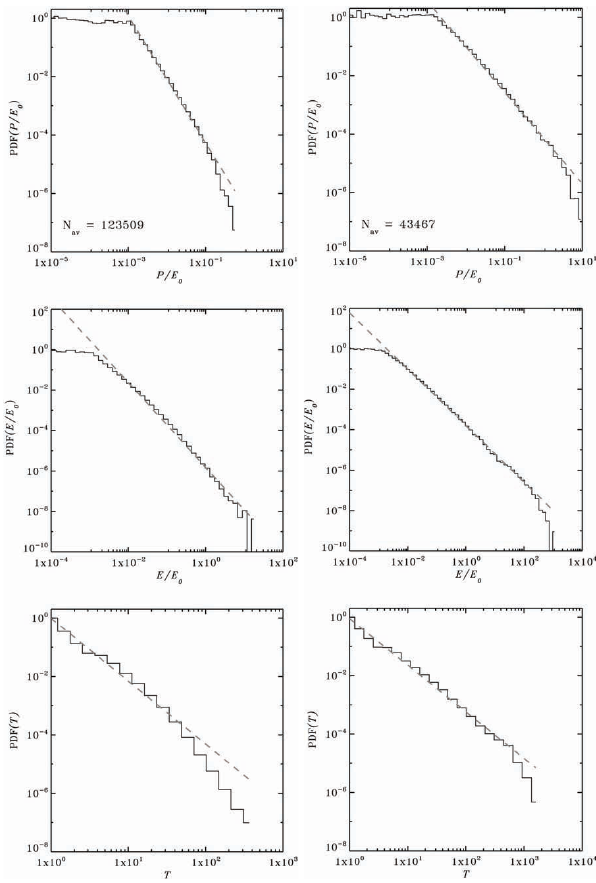
Fig. 4. Probability distribution functions of avalanche size mea- sures, E , P and T for two runs: δ + =5 (right) and δ + =1 (left). Statistics is based on simulations spanning 10 6